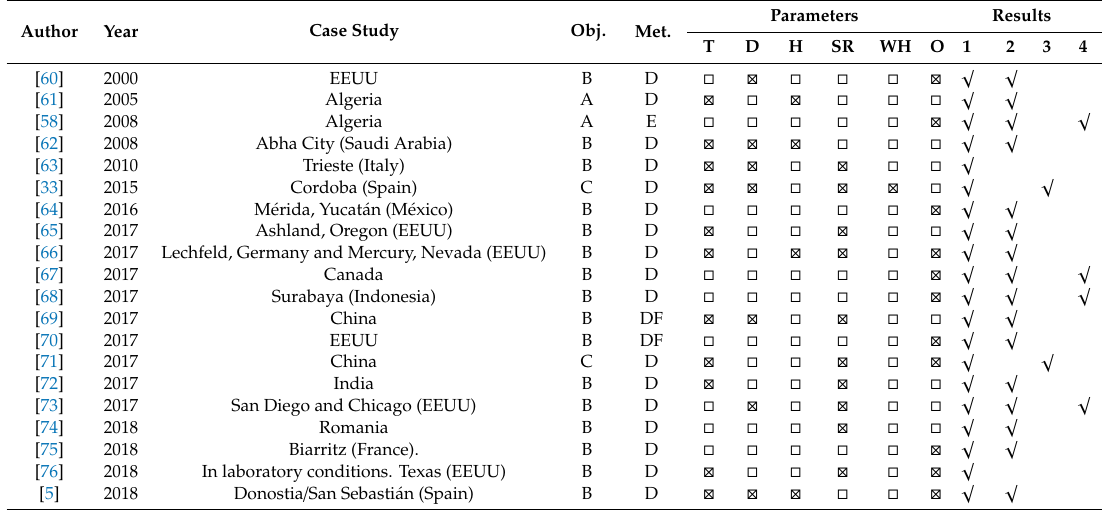
Table 2. Reviewed ANN studies in Photovoltaic